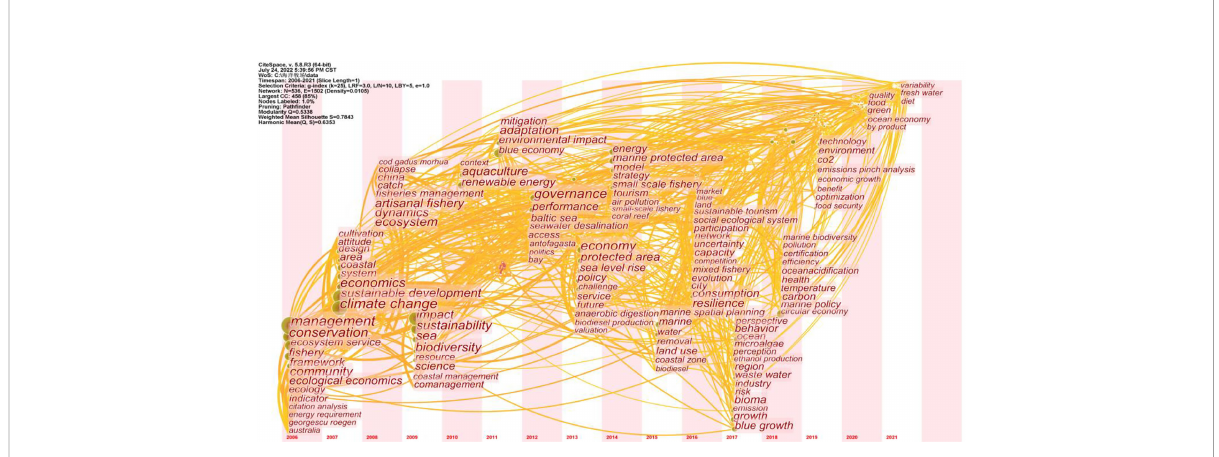
FIGURE 6 The research frontier time series knowledge